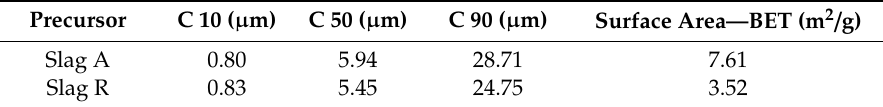
and mass ratio of K 2 O to SiO 2 is 0.62 (K 2 O = 18.46%, SiO 2 = 30.00%). Table 1. The particle size distribution of used precursors.